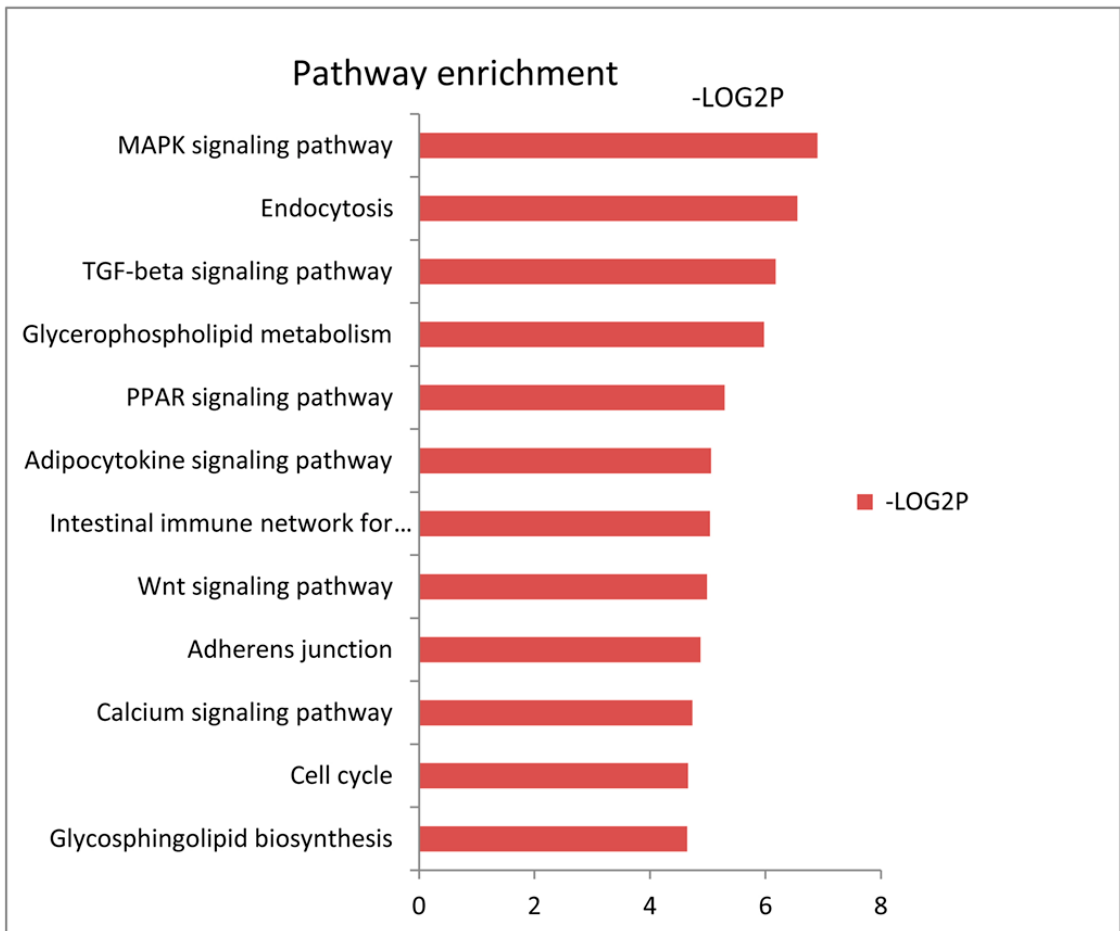
Figure 2. KEGG enrichment analysis of the targeted genes of the differentially expressed miRNAs. The horizontal axis refers to the –log2P, while the vertical axis refers to the significantly enriched pathway with a corrected p < 0.05. A higher number for –log2P value indicates the promoted performance of the pathway enrichment.